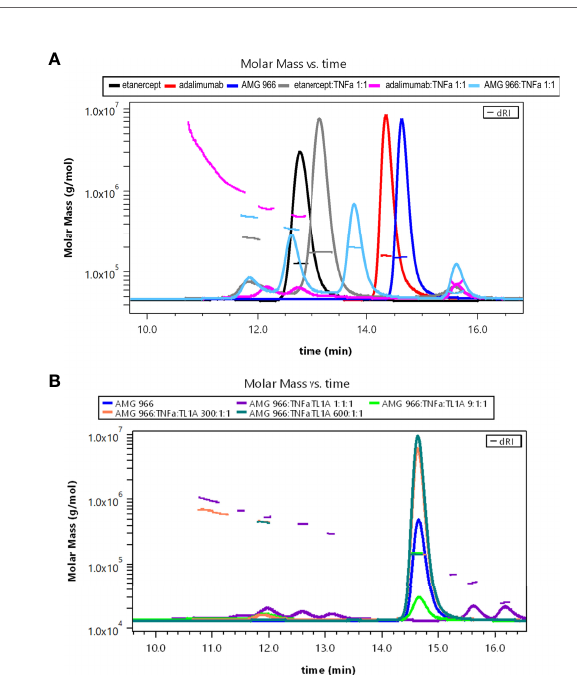
FIGURE 5 | AMG 966 forms large complexes with TNF a and TL1A in vitro . SEC-MALS analysis was performed after overnight incubation of various therapeutic proteins and trimeric target at different ratios. (A) Etanercept, adalimumab, and AMG 966 were analyzed either alone, or after being mixed in a 1:1 ratio with TNF a . (B) AMG 966 was combined with TNF a and TL1A at various ratios and analyzed.